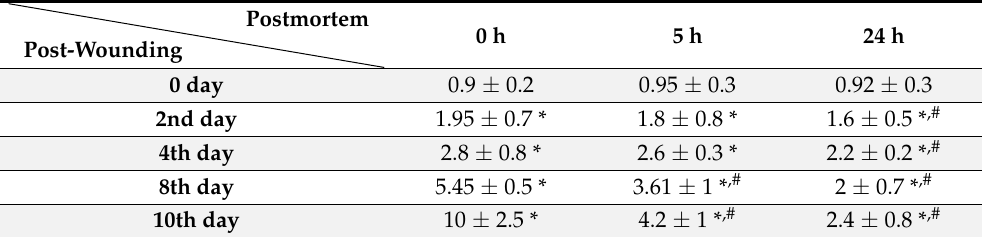
Table 2. Long noncoding fatty acid oxidation expression (mean ± SD) in the examined cutaneous samples at different post-wounding time interval and postmortem